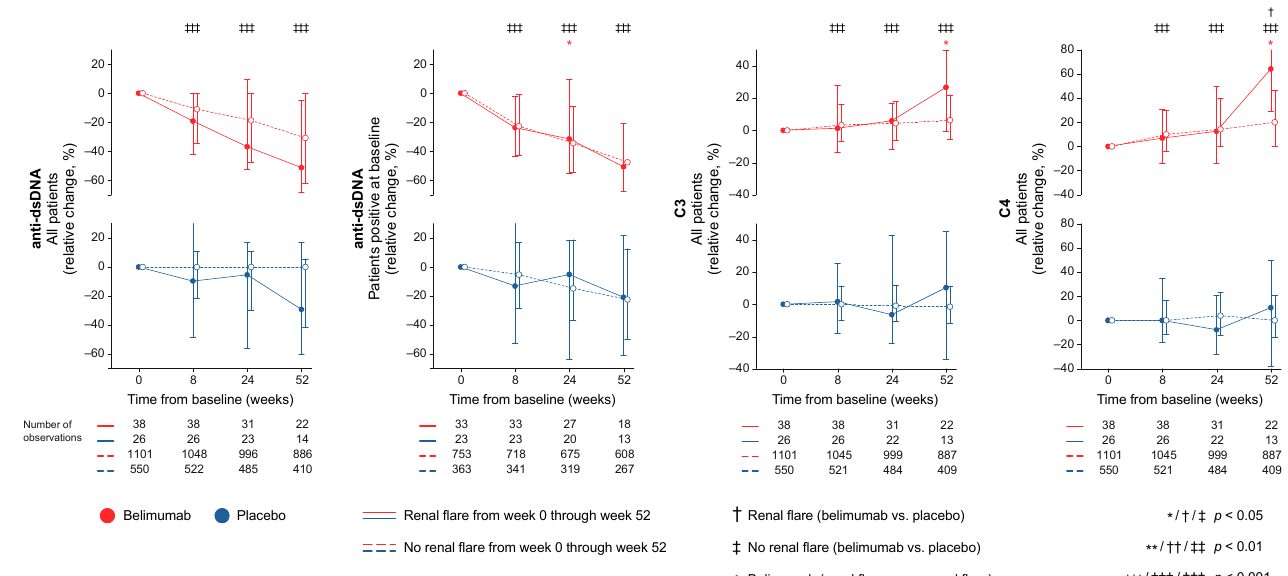
Figure 3. Changes in serological markers in relation to renal flares. The graphs delineate relative to baseline percentage changes in anti-dsDNA, C3, and C4 levels in patients who developed at least one renal flare during the study period (continuous lines) and patients who did not (dashed lines). Comparisons between patients who flared and patients who did not were conducted using multivariable logistic regression analysis to account for potential confounders and are illustrated for patients who received non-biological standard therapy plus belimumab (red lines) and patients who received non-biological standard therapy alone (blue lines). For anti-dsDNA levels, a separate analysis for patients with positive anti-dsDNA levels ( ≥ 30 IU/mL) at baseline is also demonstrated. Comparisons between treatment arms were conducted using non-parametrical Mann–Whitney U tests. Whiskers indicate the interquartile range of distributions. The number of patients with available data at each time point is indicated for each patient subgroup. Anti-dsDNA: anti-double-stranded DNA antibodies; C3: complement component 3; C4: complement component 4.